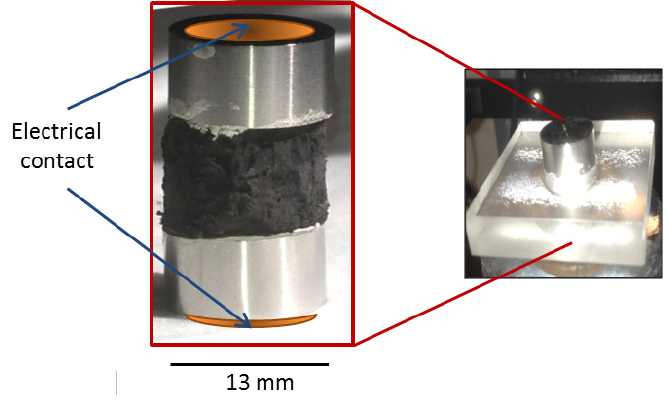
Figure 9. Anvils and sample placement for simultaneous mechanical and electrical